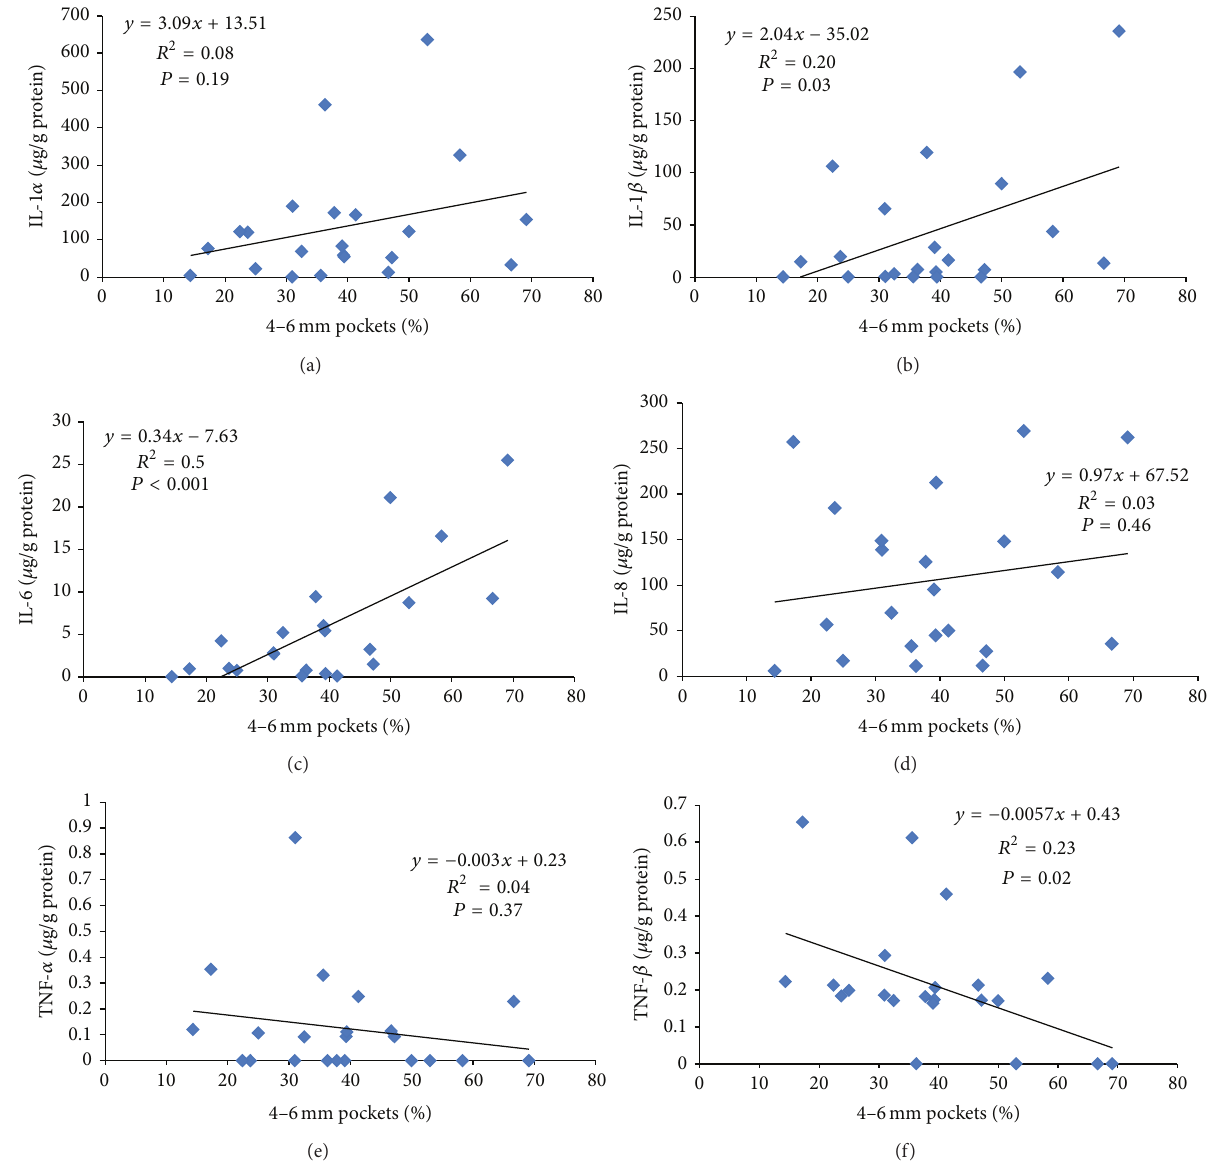
Figure 1: Scatter plots of baseline proinflammatory cytokines and 4–6 mm pocket percentages (before treatment) in patients with chronic periodontitis. (a) Interleukin-1 𝛼 (IL-1 𝛼 ). (b) Interleukin-1 𝛽 (IL-1 𝛽 ). (c) Interleukin-6 (IL-6). (d) Interleukin-8 (IL-8). (e) Tumor necrosis factor 𝛼 (TNF- 𝛼 ). (f) Tumor necrosis factor 𝛽 (TNF- 𝛽